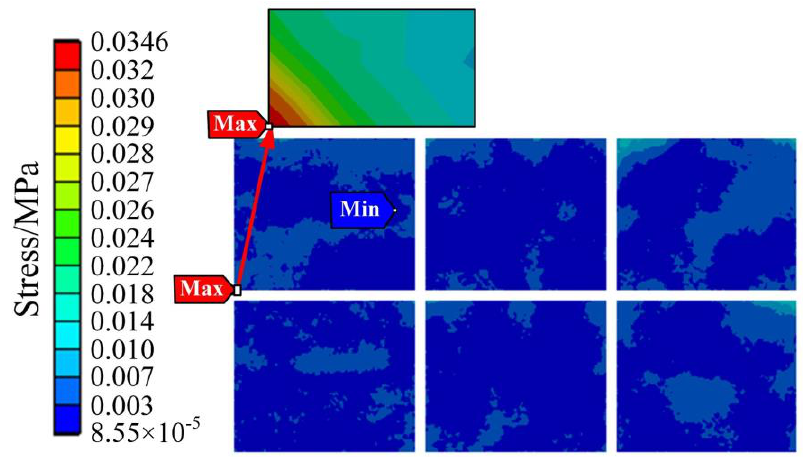
Figure 17. The stress of DBC solder layer under the first order mode.